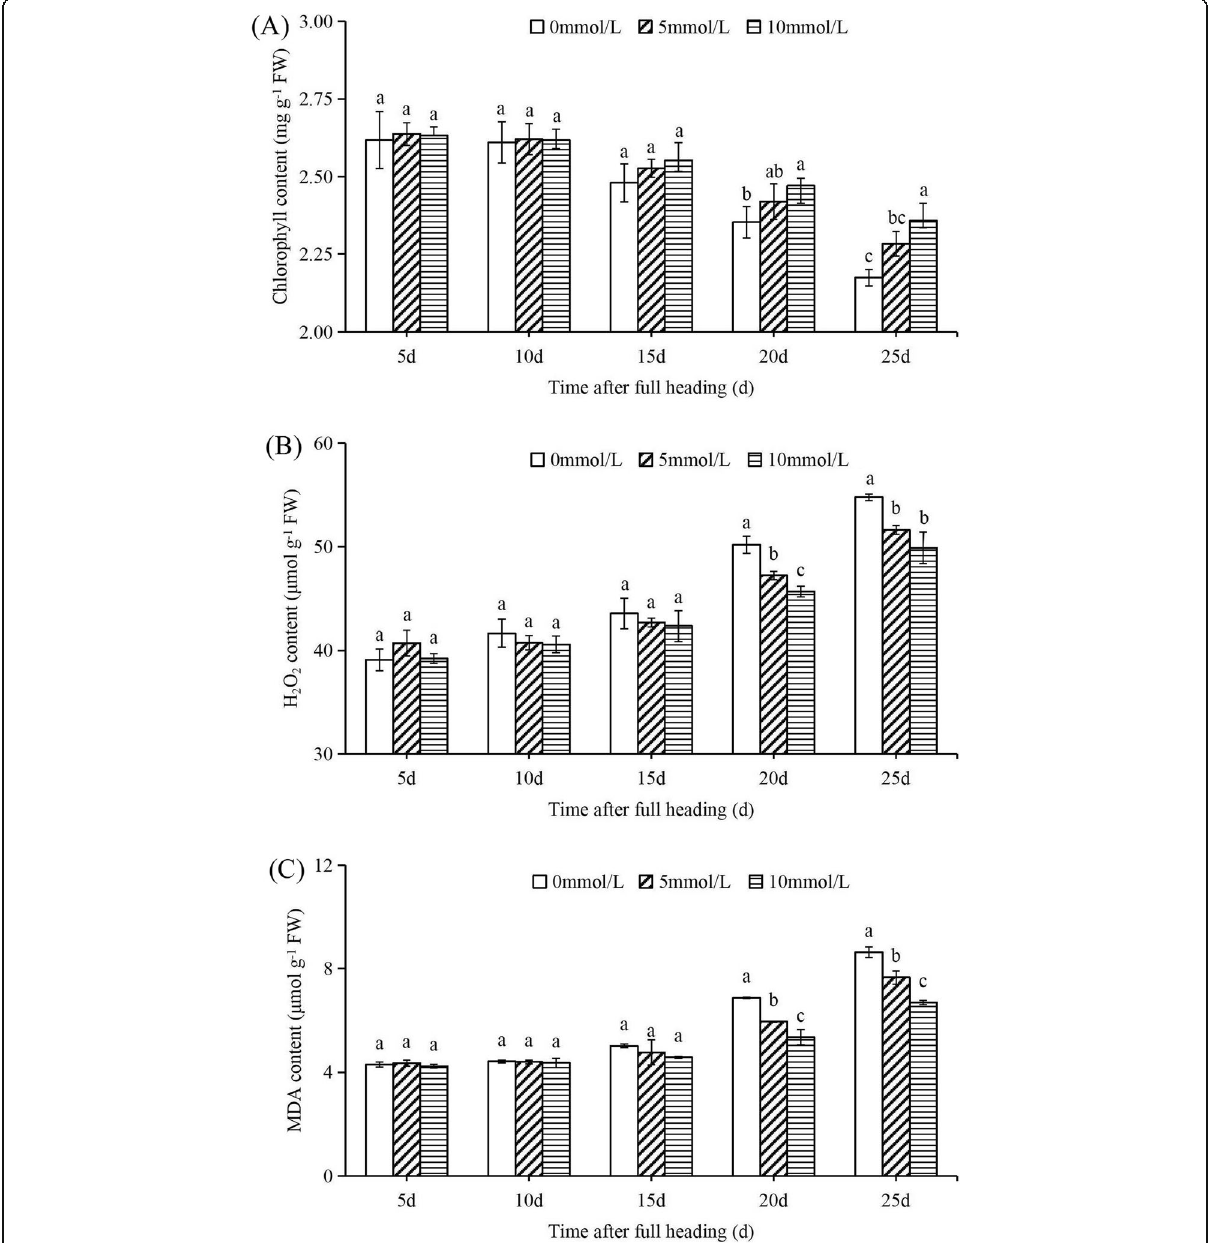
Fig. 8 Chlorophyll, H 2 O 2, and MDA content of rice after exogenous spraying of allantoin at different concentrations after full heading. After 60 days of growth, the rice reached the peak stage, and then the leaf was sprayed with different concentrations of allantoin (0 mmol/L, 5 mmol/L, and 10 mmol/L) every 5 days. The sword leaves of rice were used for the determination of chlorophyll ( a ), H 2 O 2 ( b ) and MDA ( c ) content. FW, fresh weight. Values are means±SEM, n = 3. Significant differences ( P < 0.05) are denoted by different lowercase